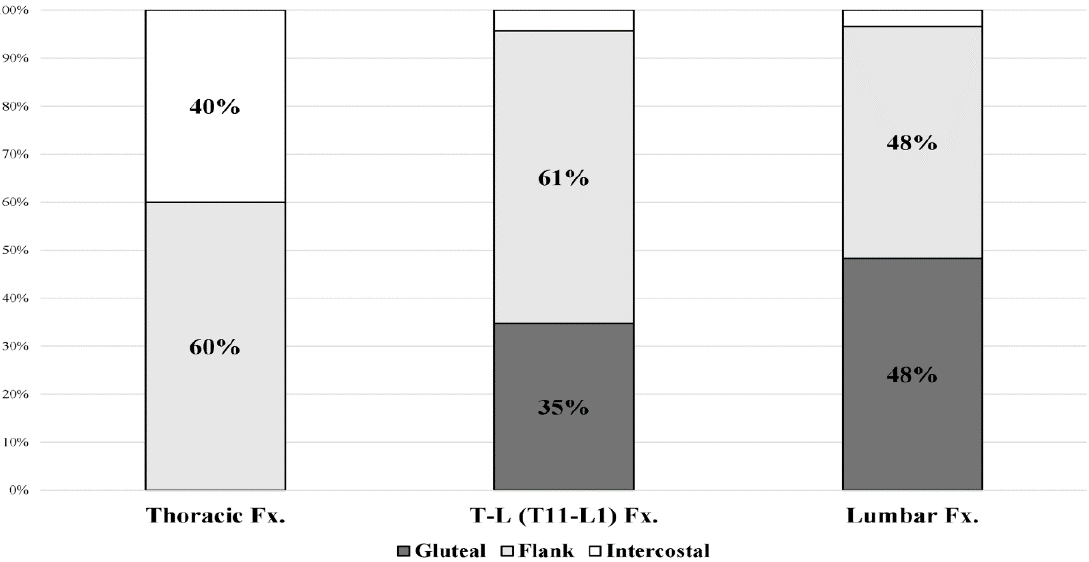
Figure 5. Paraspinal pain distribution according to vertebral fracture level. T-L: thoraco-lumbar.